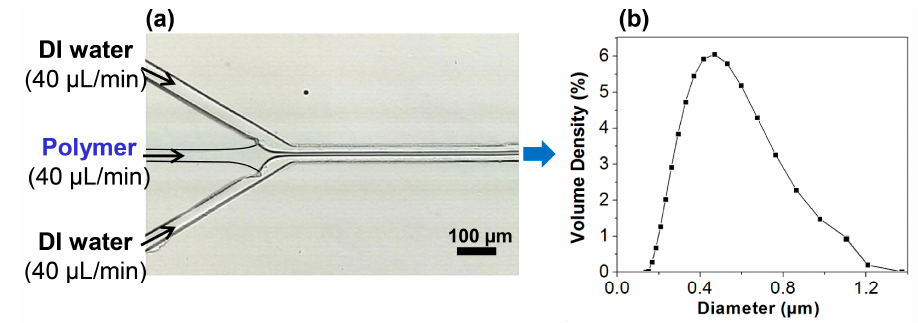
Figure 5. ( a ) Visualization of the focusing flow in the microchannel; ( b ) Size distribution of HPNCs.